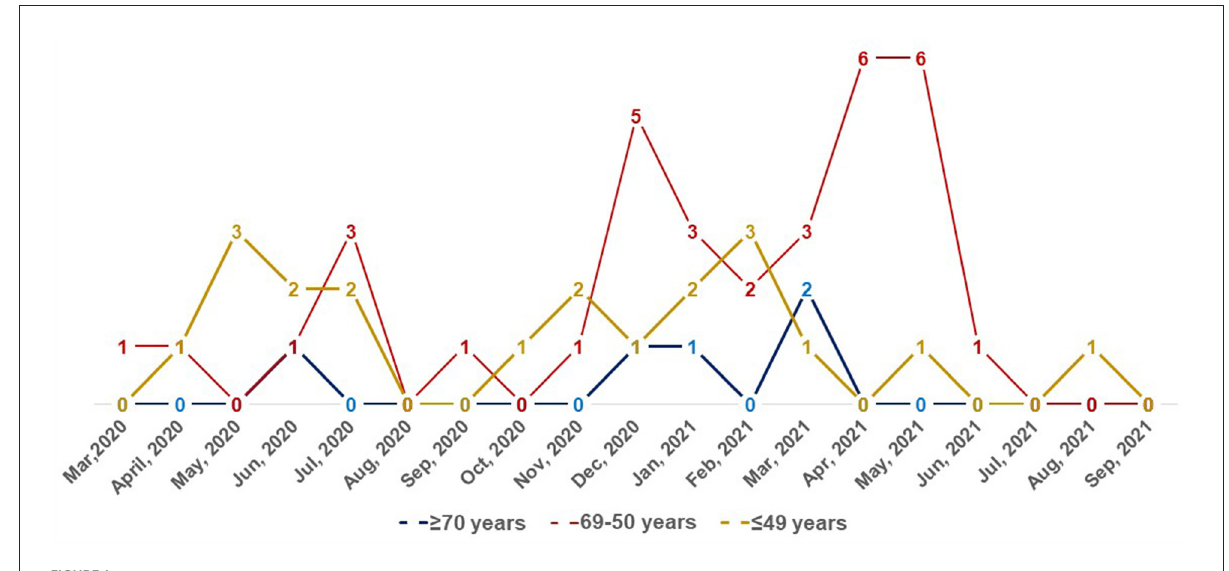
FIGURE1 Frequency of COVID-19 (number) in asthmatic patients from March 2020 to September